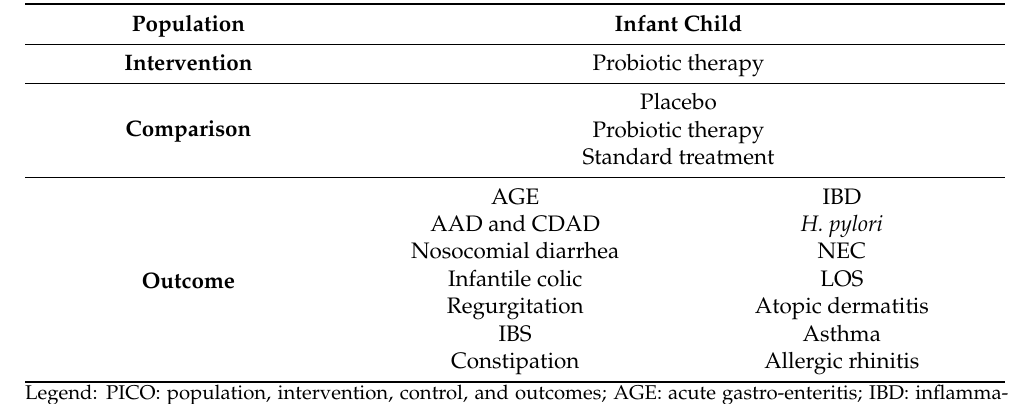
Table 1. PICO search